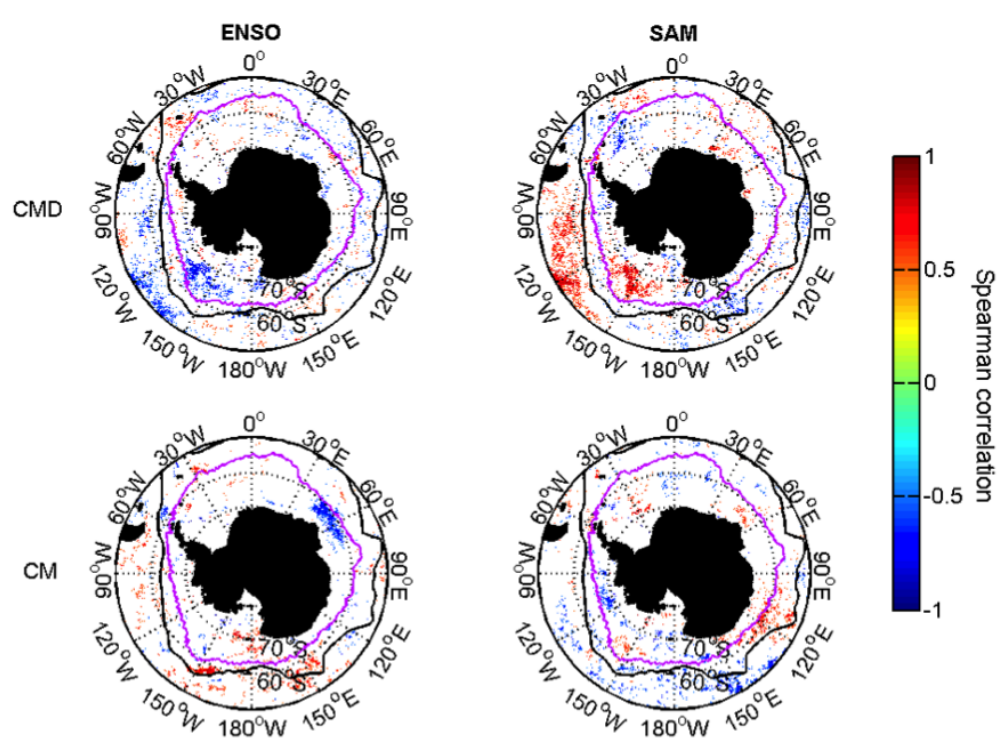
Figure 8. Correlation coefficients of the standardized anomalies of date of Dia-Chla maximum (CMD) and Dia-Chla maximum (CM) vs. ENSO (MEI) and SAM (AAO) indices. Only statistically significant trends ( p < 0.05) are shown. Black lines show the mean position of the Polar Front [43] over 1997–2012. Purple line displays the median position of the maximum sea ice extent [45] over